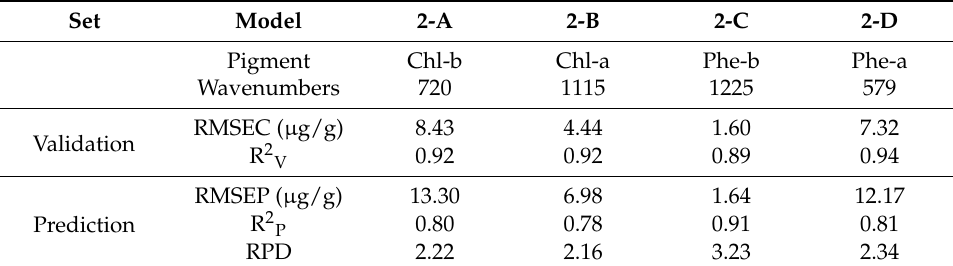
Table 3. The biPLS model results based on the extracted